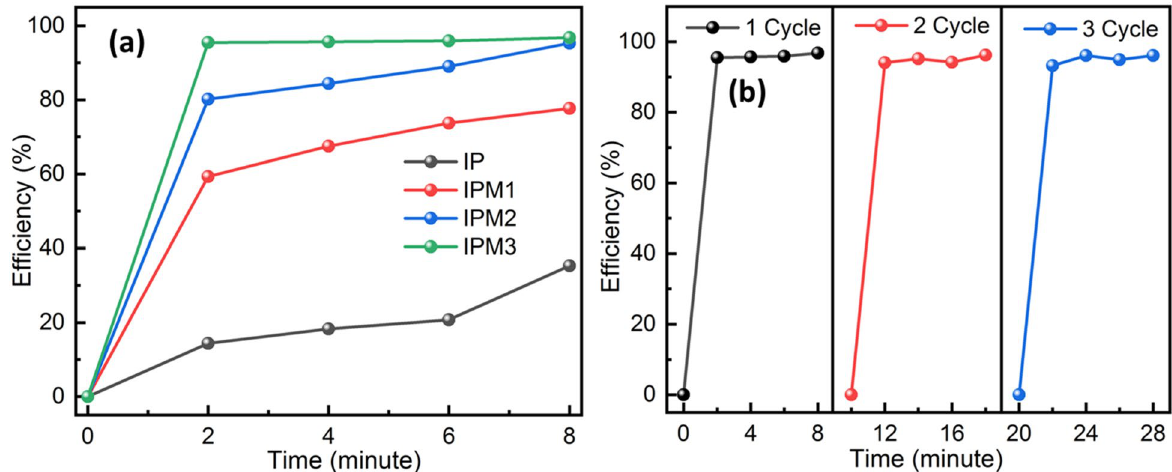
Figure 9. ( a , b ) Photodegradation efficiency of sample IP, IPM1, IPM2, and IPM3 under sunlight, ( b ) Reusable photocatalyst test for sample IPM3 indicating its